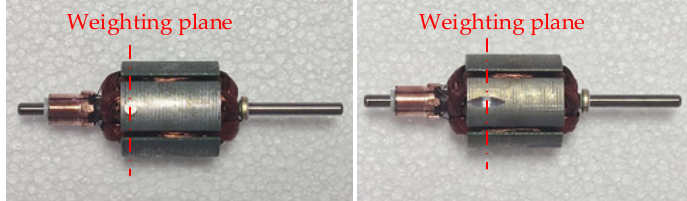
Figure 5. The plane of micromotor armature during trial weighting and milling.